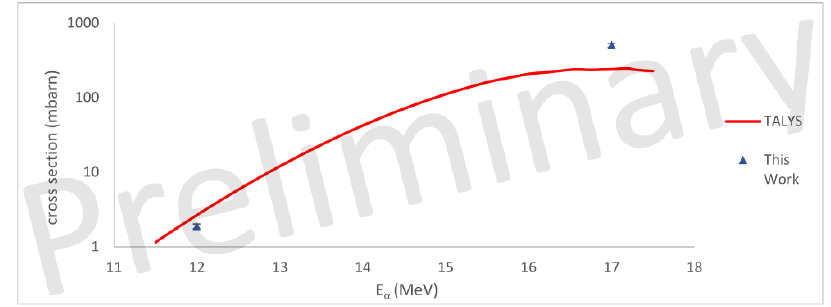
Fig. 3. The preliminary results of this work in the case of 124 Te(α,n) 127